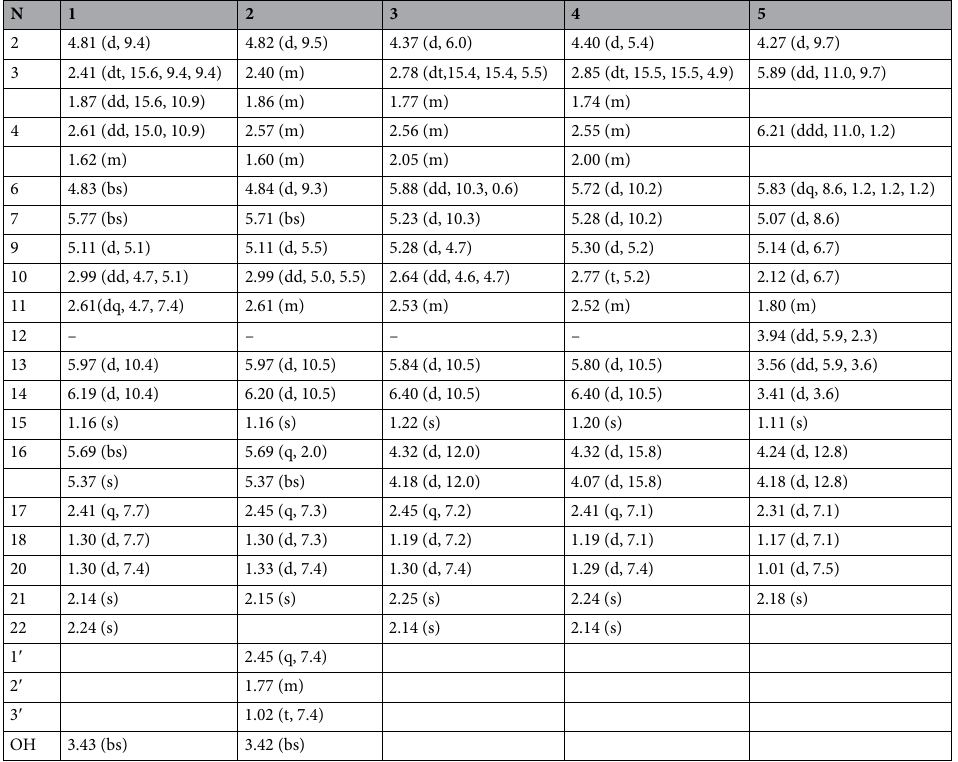
Table 1. 1 H NMR data ( δ in ppm, J in Hz) of briaranes 1–5 at 500 MHz in CDCl 3